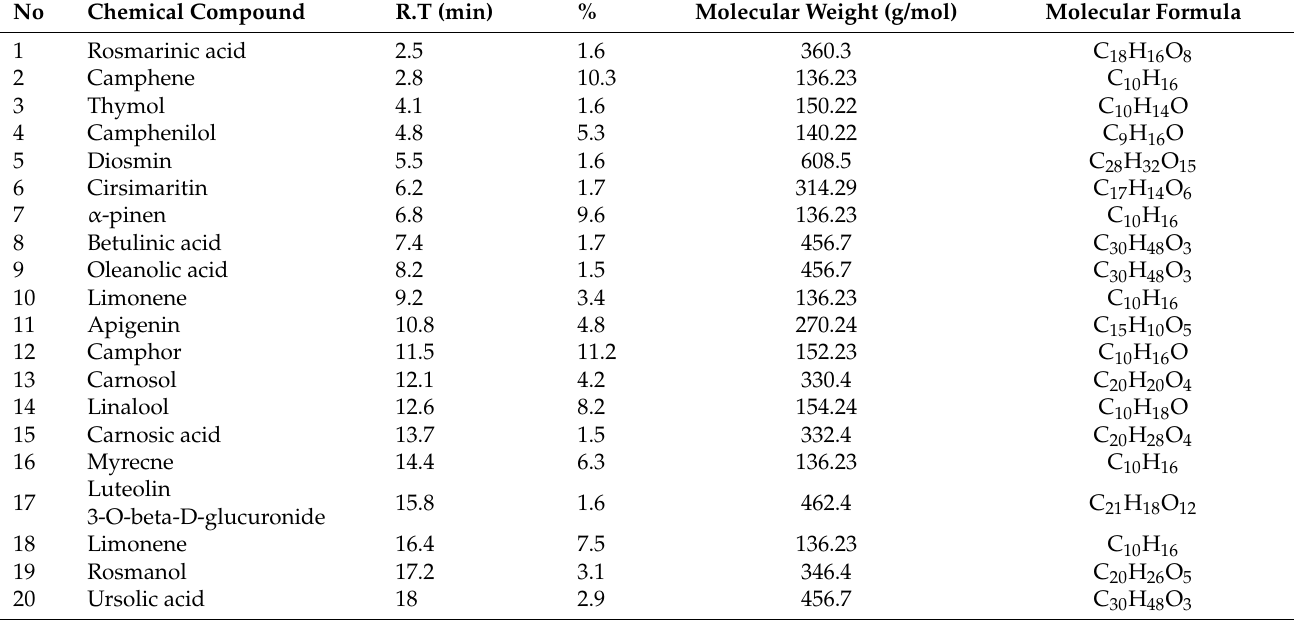
Figure 7. LC-MS chromatogram from R. officinalis extracts obtained by using DES3: CHGl. Table 5. Tentative identification of chemical constituents in the R. officinalis extract was obtained using DES2: